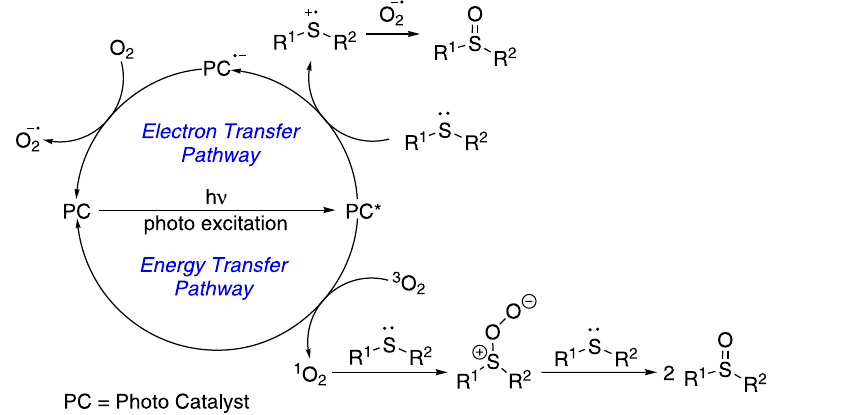
Figure 1. Photo oxidation of thioethers into sulfoxides.